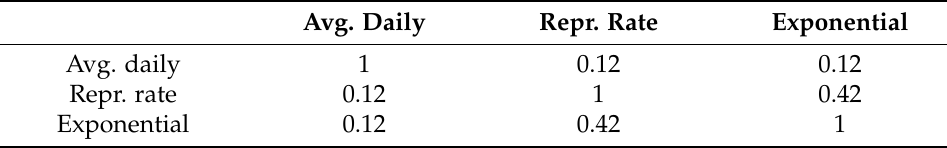
Table 2. Correlation between the three classes (binarized infection